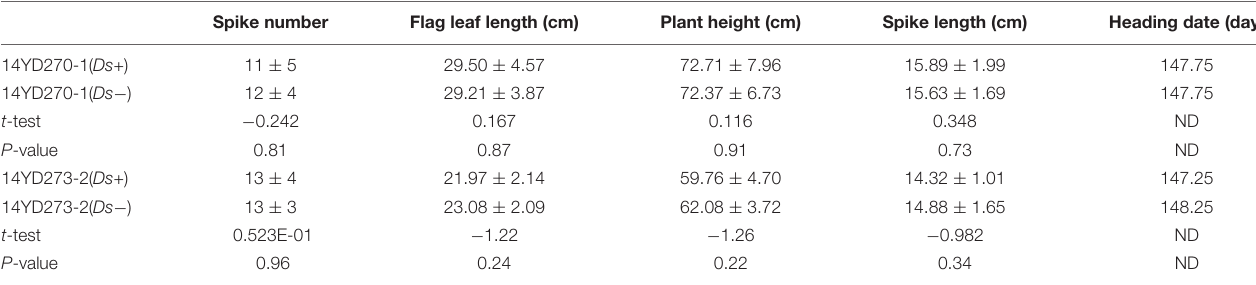
FIGURE 7 | Disease phenotypes of three pBDL23-transformed marker-free rice lines inoculated with rice blast isolate TMC-1. T2 homozygote plants from transgenic lines 14YD270-1, 14YD273-2, and 14YD271-3 were tested; NPB: the transgenic recipient rice line Nipponbare; CO39: a rice blast susceptible cultivar; Pi9: a resistant rice line carrying the Pi9 rice blast resistance gene (Qu et al., 2006). TABLE 4 | Evaluation of agronomic traits of two pBDL23-transformed marker-free rice lines. Spike number Flag leaf length (cm) Plant height